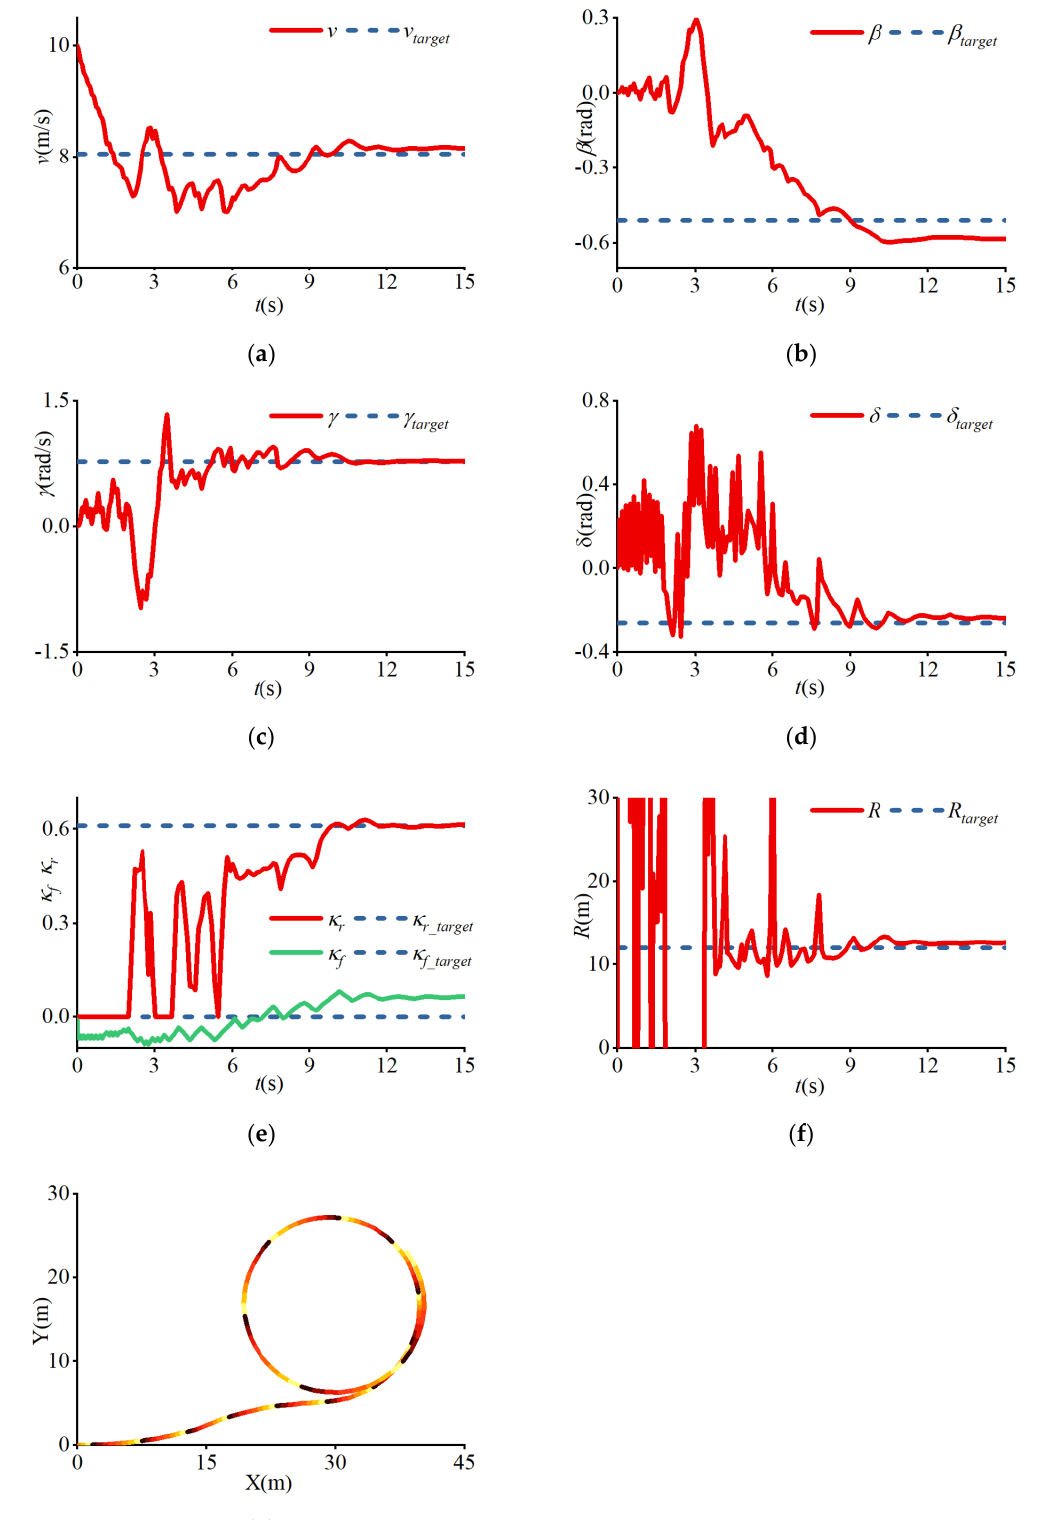
Figure 7. The simulation result with the 10 m/s original velocity and the target group (c): ( a ) the velocity; ( b ) the sideslip angle; ( c ) the yaw rate; ( d ) the steering angle; ( e ) the TYDEX longitudinal slip ratios of the front and rear tires; ( f ) the radius of the motion curve; ( g ) the motion curve of the vehicle. All continuous lines suggest the simulation results, while the dashed lines suggest the targets.